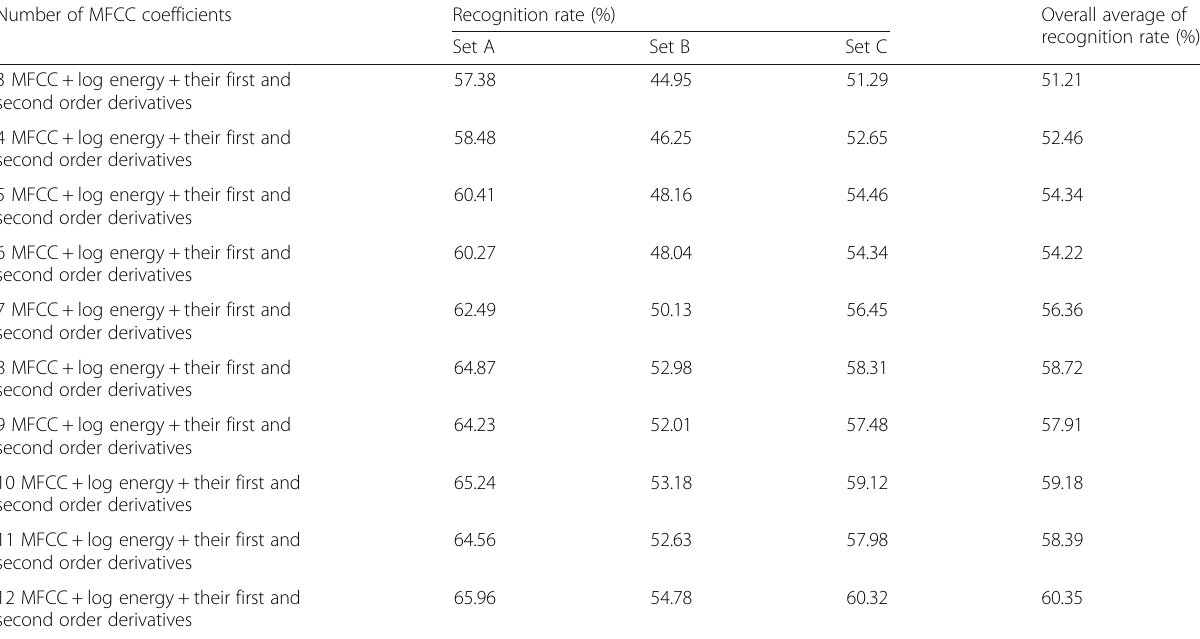
Table 2 Comparison of overall average recognition rates of different number of MFCC features with Fisher-Markov selector on three test sets of Aurora 2 task